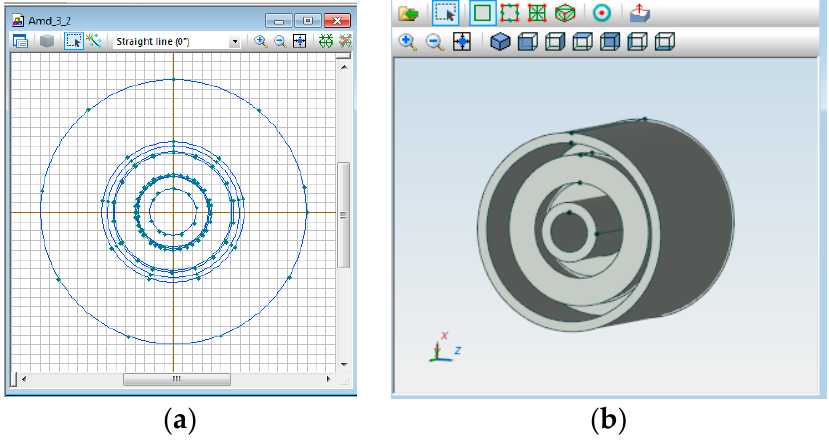
Figure 5. The AMD geometric model: ( a ) 2D model with windings, and ( b ) 3D model without windings.